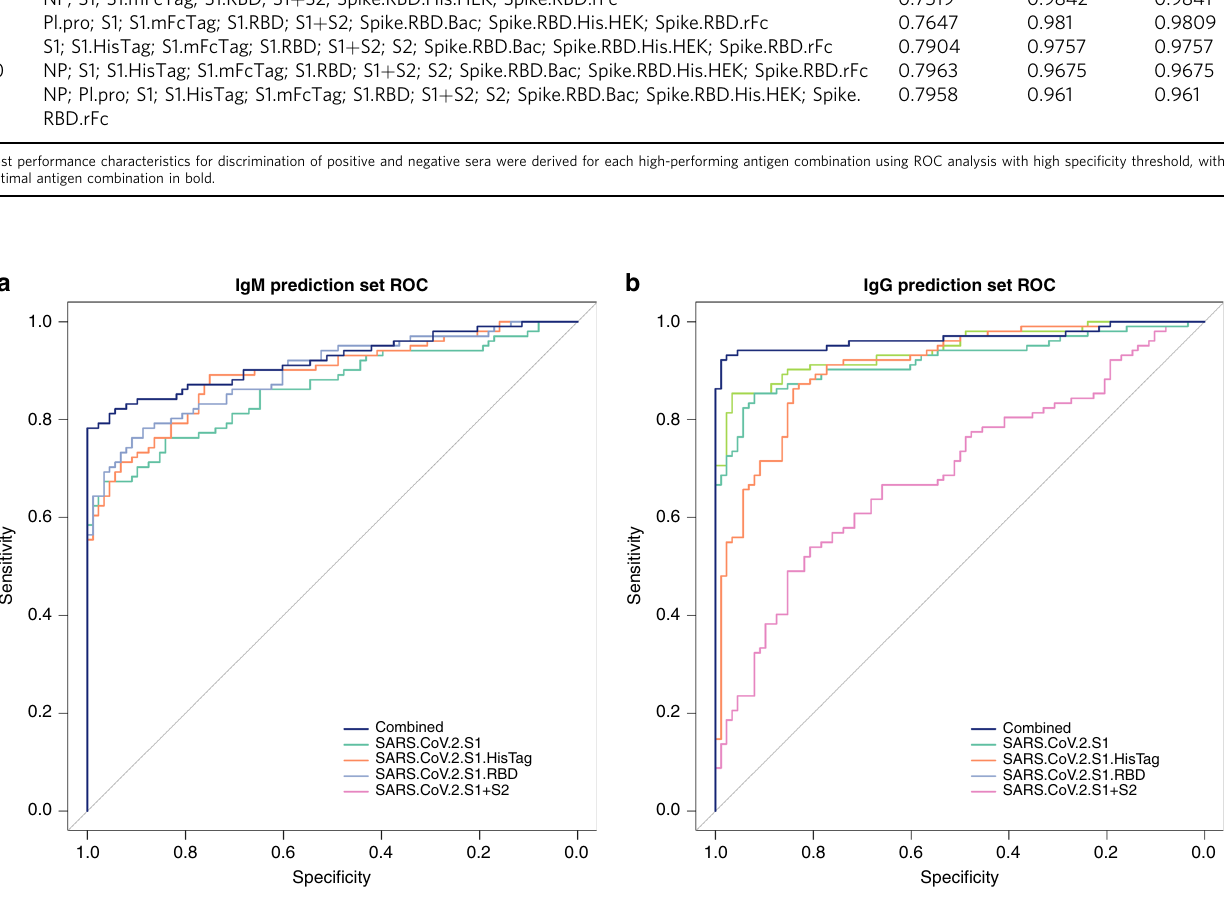
Fig. 3 ROC curves for high-performing combination of antigens. ROC curves showing sensitivity versus speci fi city for discrimination of positive and negative blood specimens were derived for each combination of the high performing antigens for both IgM ( a ) and IgG ( b ) and compared to no discrimination (ROC AUC = 0.5, gray line). Source data are provided as a Source data